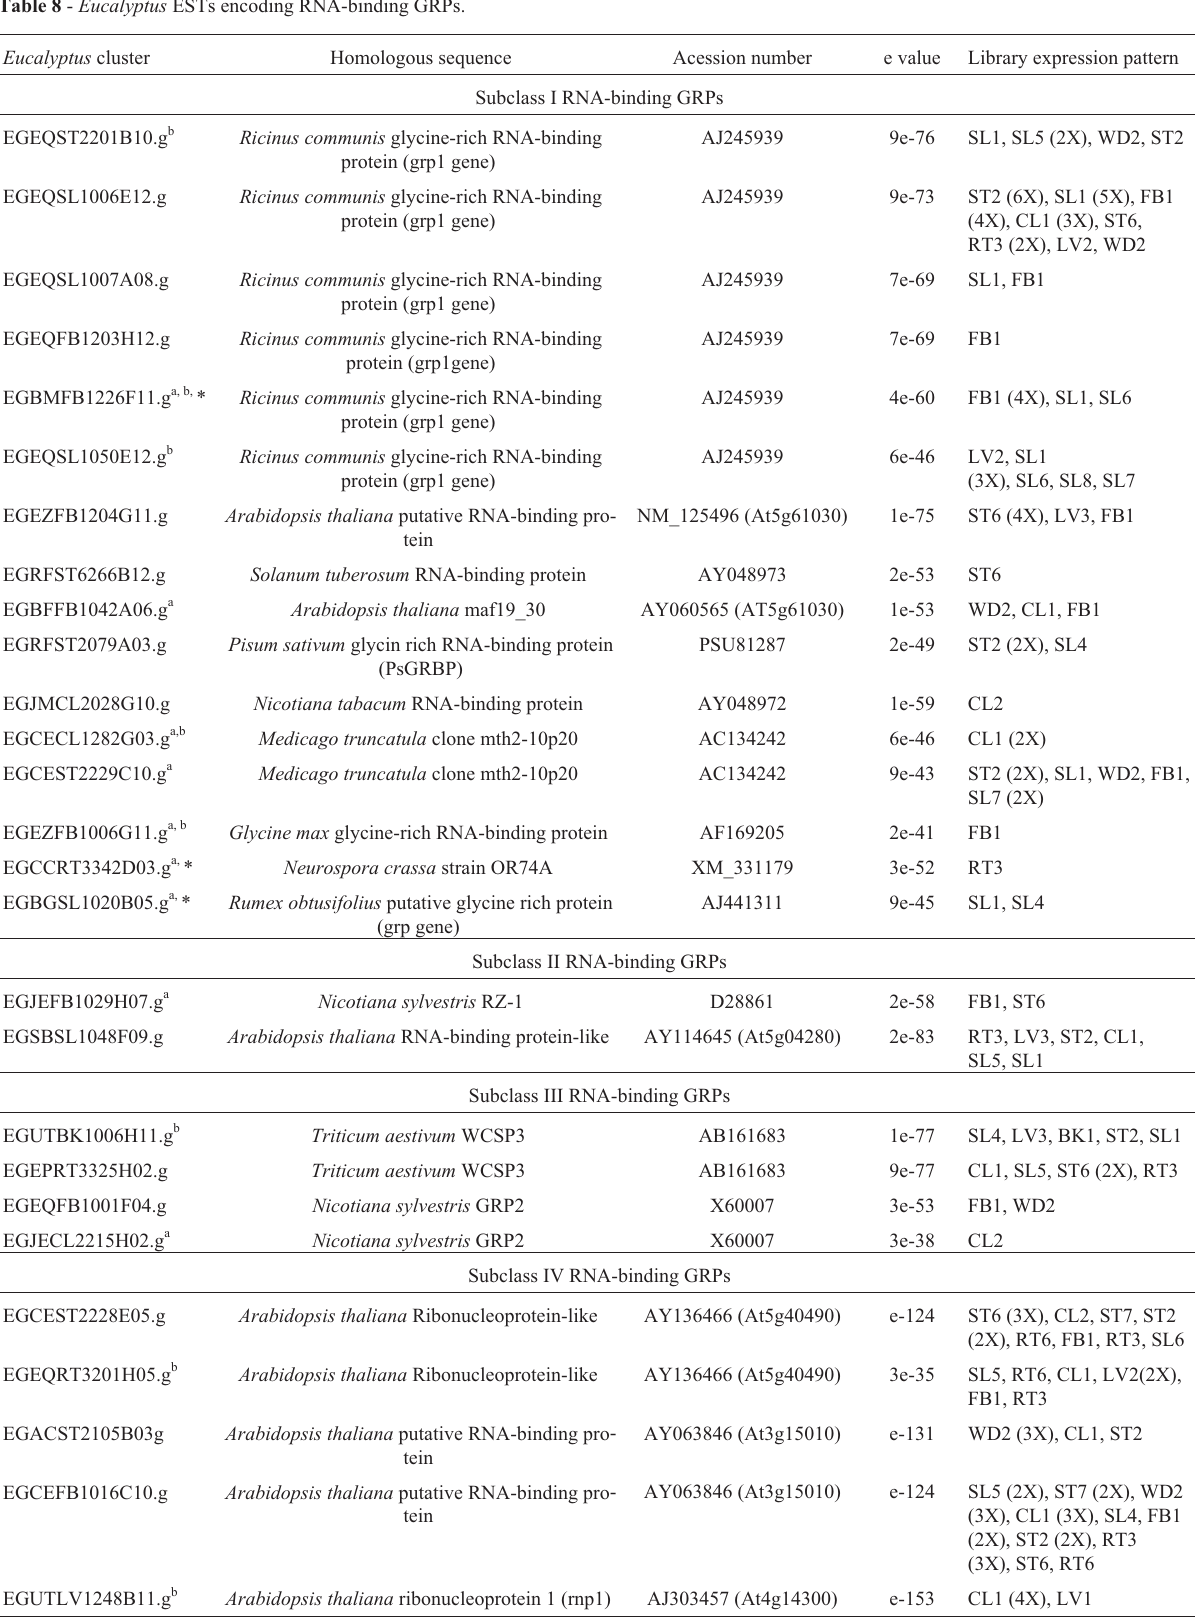
Table 8 - Eucalyptus ESTs encoding RNA-binding